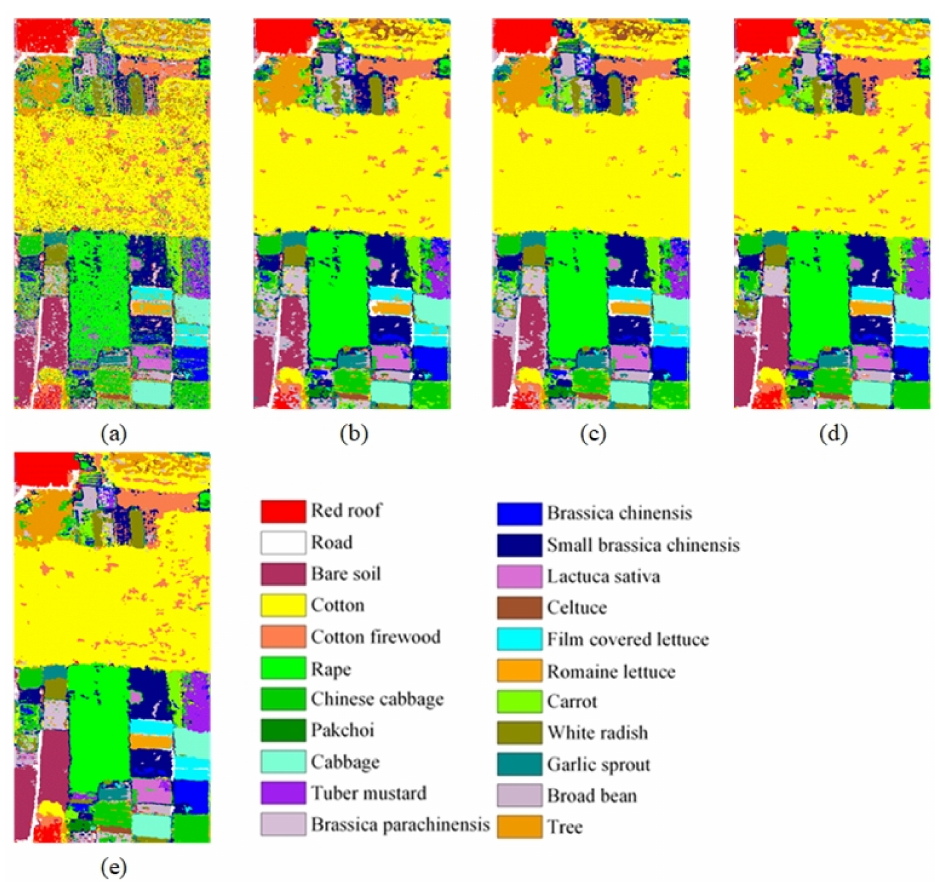
Figure 16. The classification results for the Honghu dataset using RF: ( a ) Pixel-wise spectral classifi- cation; ( b ) MLF; ( c ) MPF; ( d ) MLV; ( e )